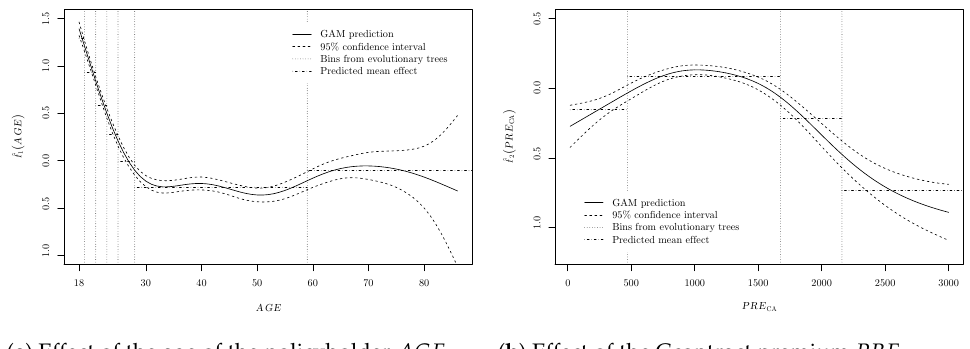
( b ) Effect of the Ccontract premium PRE CA . Figure 6. Illustration of the prediction effect from the Cox model ( ˆ f 1 and ˆ f 2 ) in Equation (3) and of the bins obtained from evolutionary trees for the age of the policyholder AGE and the contract premium PRE CA in the CA cohort.